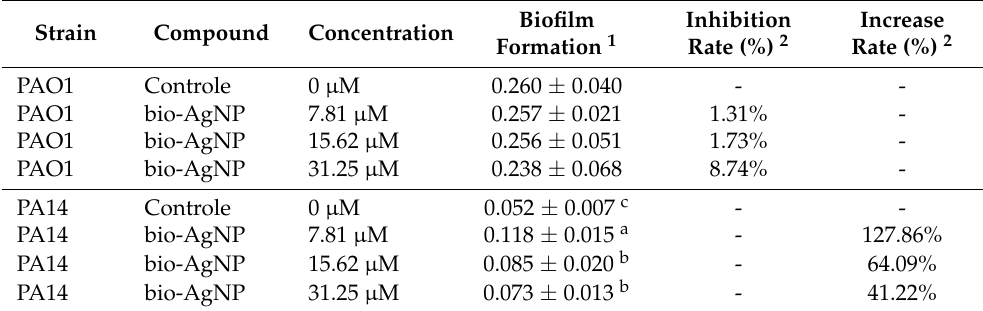
Table 2. Biofilm formation in P. aeruginosa after treatment with different subinhibitory concentrations of silver nanoparticles.